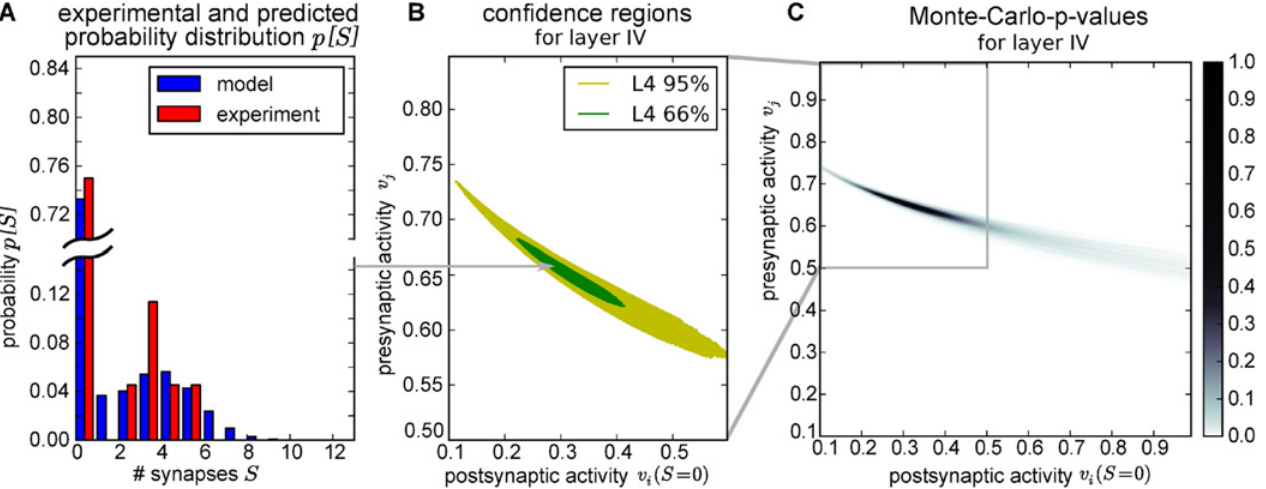
Figure 4. Model can account for experimental data for suitable pre- and postsynaptic activities. (A) The probability distribution of the number of synapses between two neurons from experiment ([36], red) is similar to the distribution resulting from the proposed model (blue) at v j = 0.656 and v i ( S = 0) = 0.2975. (B) The activity confidence regions, where error of the experimental outcome lies within the most probable 95% (yellow) or 66% (green) of the trials, when randomly sampling from model distribution, spans over a broad range of activities. (C) Colour code shows the Monte-Carlo p-values for the hypothesis that experimental data comes from model distribution. For comparability, postsynaptic influence I was transformed to the postsynaptic activity for S = 0 in all figures. (Parameters: BCM rule with synaptic scaling with θ = 0.08, v tss = 0.1, κ = 9.0, structural plasticity: P = 12, ln p build = − 16, a = 2.0, ρ = 0.125)